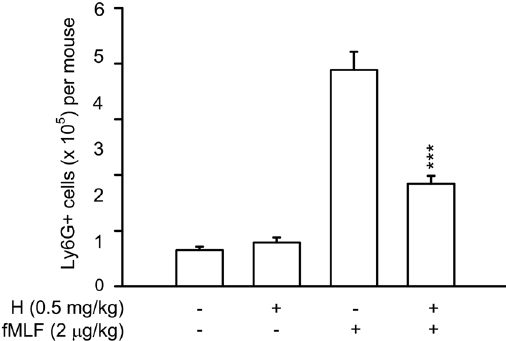
Figure 10. Honokiol inhibits neutrophils accumulation in the peritoneal cavity in fMLF-stimulated mice. Male BALB/c mice aged 7–8 weeks were pretreated by intraperitoneal injection of honokiol (0.5 mg/kg body weight) or vehicle alone (10% DMSO/normal saline) for 30 min, and then challenged with intraperitoneal injection of fMLF (2 μ g/kg in normal saline) for 2 h. The peritoneal cells were harvested and stained with the Ly6G (Gr- 1) rat anti-mouse, PE conjugated monoclonal antibody for 30 min at 4 °C. The number of Ly6G positive cells were detected by flow cytometry. Data are expressed as the mean ± S.E.M. ( n = 7 in each group). *** P < 0.001 compared with